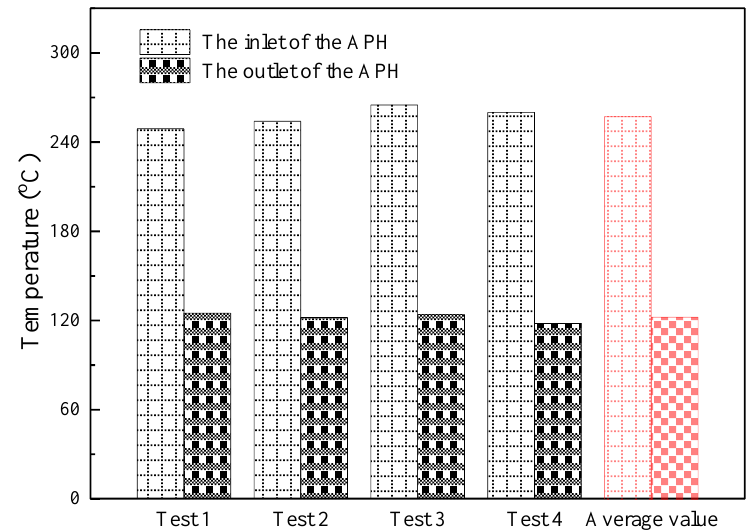
Figure 5. Flue gas temperatures at the inlet and the outlet of the APH.